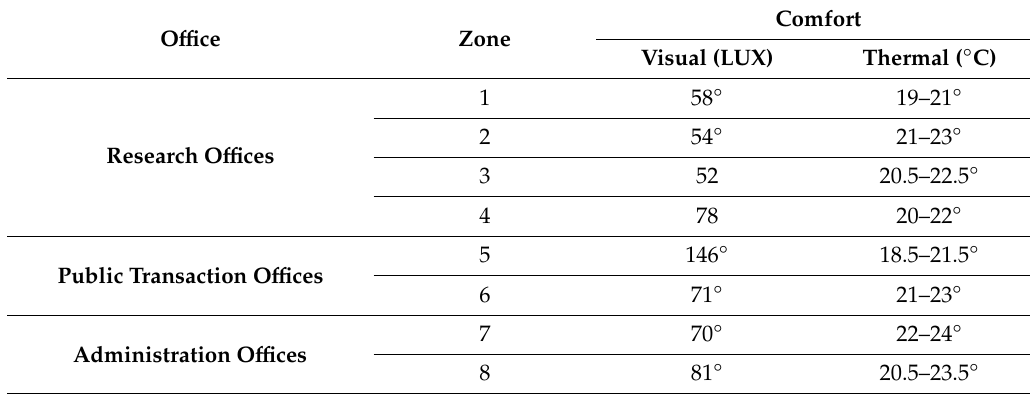
Table 5. Comfort